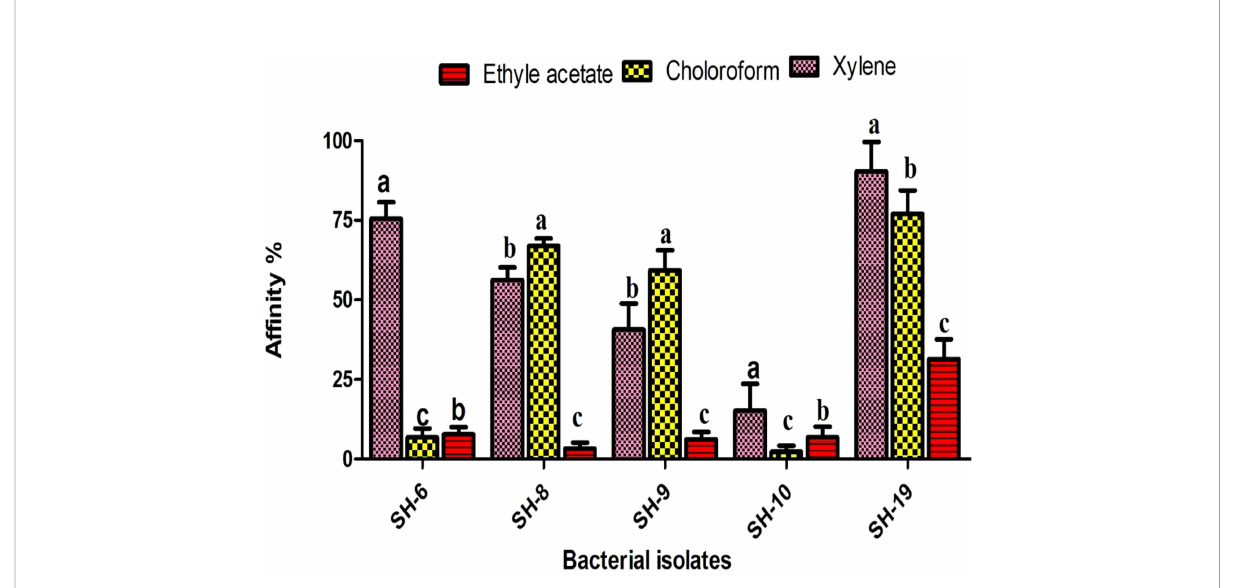
FIGURE 2 Information of the fi ve selected isolates and their af fi nity for different solvents. The letter on each bar is the signi fi cant different between treatments at P ≤ 0.05. The error bar represents the standard error among the